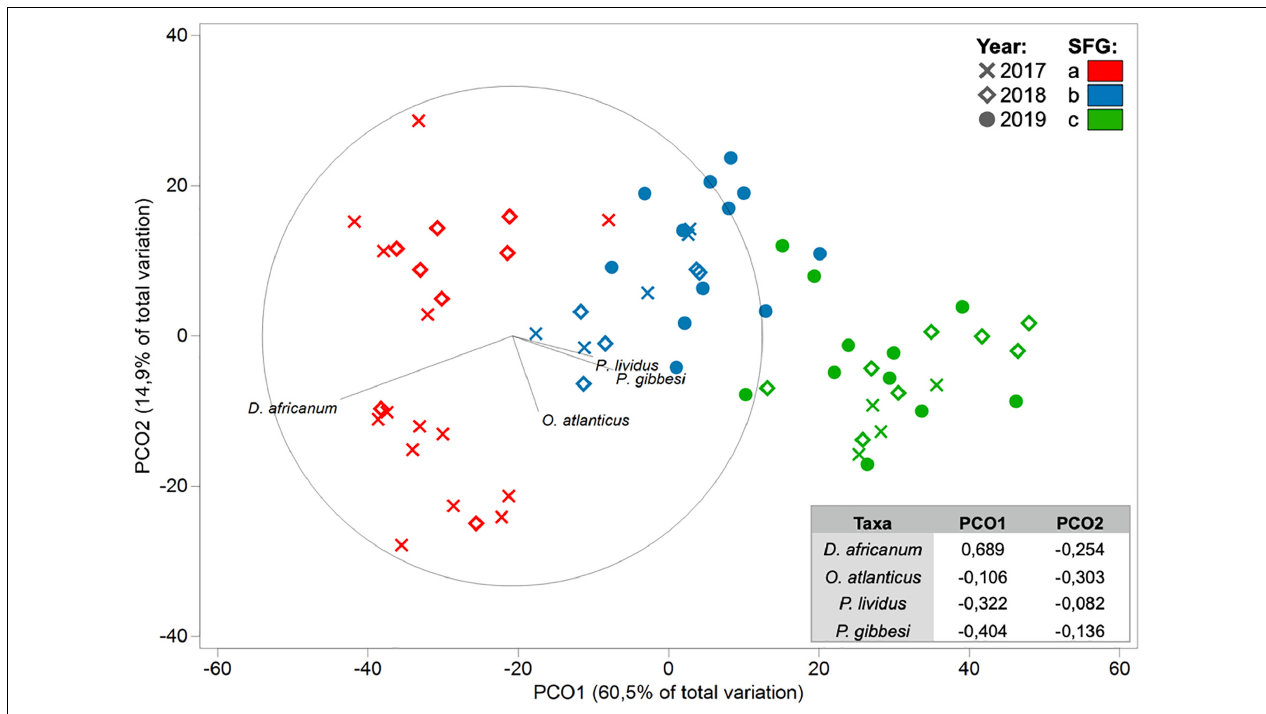
FIGURE 5 | Principal Coordinate Ordination (PCO) plot of benthic transect samples for each of the three considered years (2017, 2018, 2019; shapes) with SIMPROF-routine generated Functional Groups (SFG = a, b, and c; colors) and correlations between the four DistLM selected taxa (vectors) and PCO axes (bottom-right